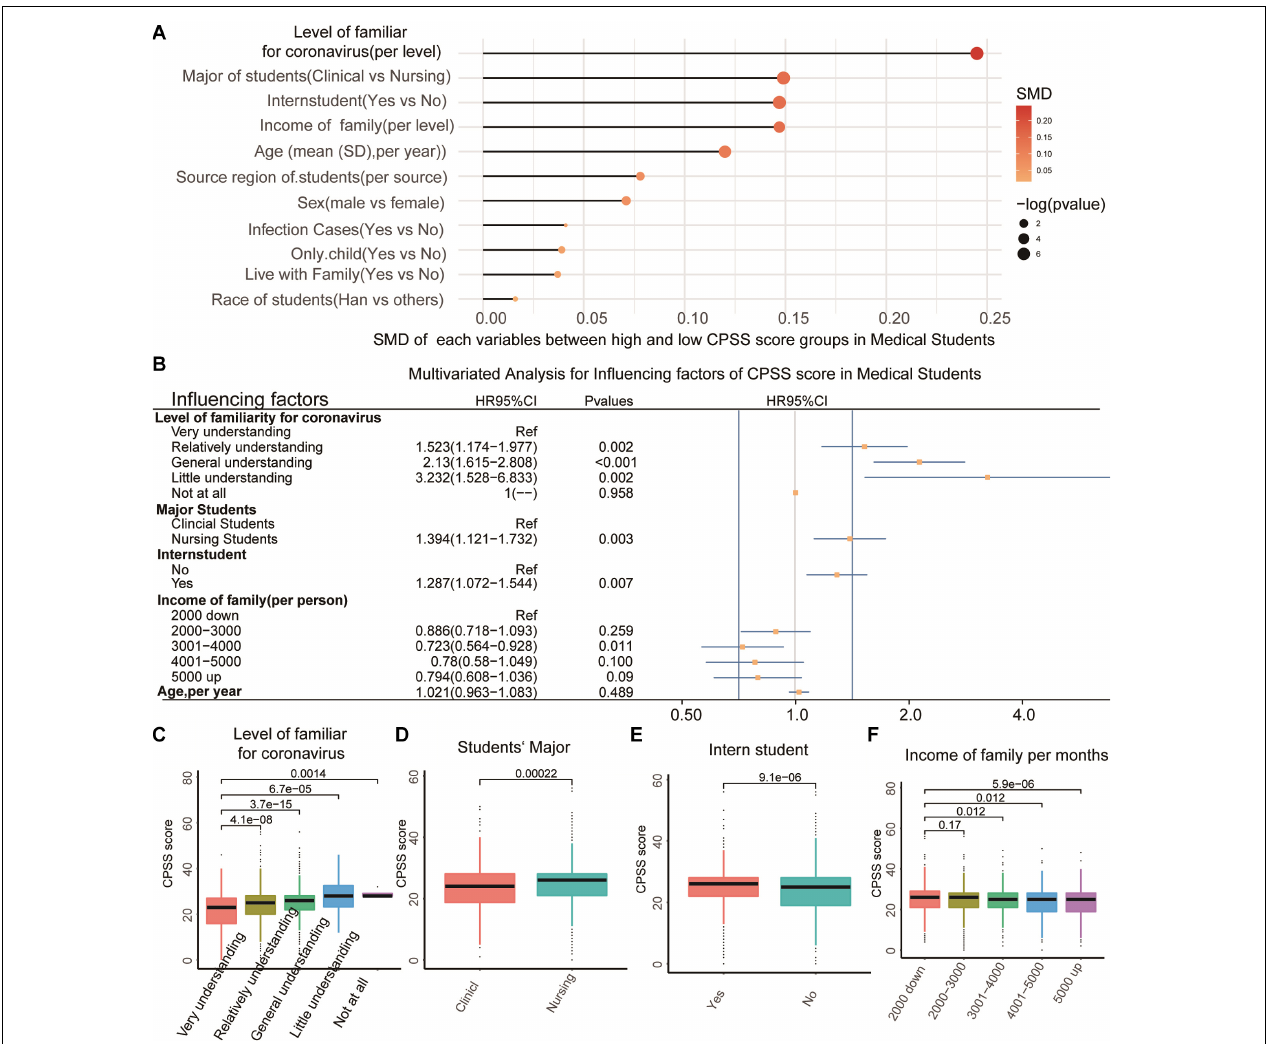
FIGURE 3 | Association of common variables with the CPSS score. (A) The SMD value of each variable between high CPSS score and low CPSS score in medical students. (B) The multivariable regression for the high CPSS score in medical students. (C–F) The significant difference of CPSS scores with four influencing